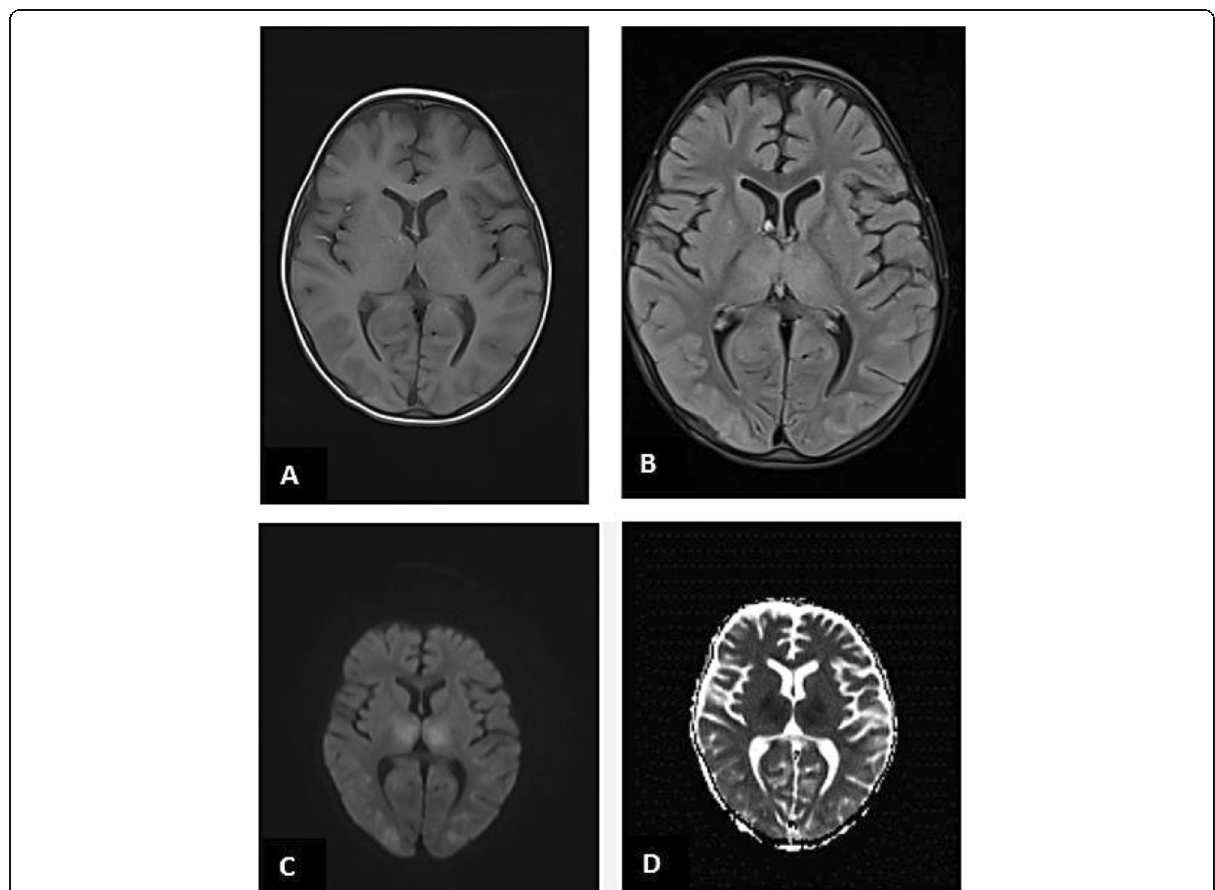
Fig. 6 Atypical pattern of posterior reversible encephalopathy syndrome. Female patient, 2 years old, diagnosed with ALL at the induction phase. Axial MRI images of the brain at the level of the thalamus. a T1WI, b FLAIR, c DWI, and d ADC show bilateral thalamic and occipital cortical and subcortical areas of faint low signal in T1WI and faint bright signal in FLAIR images with diffusion restriction in DWI and ADC map